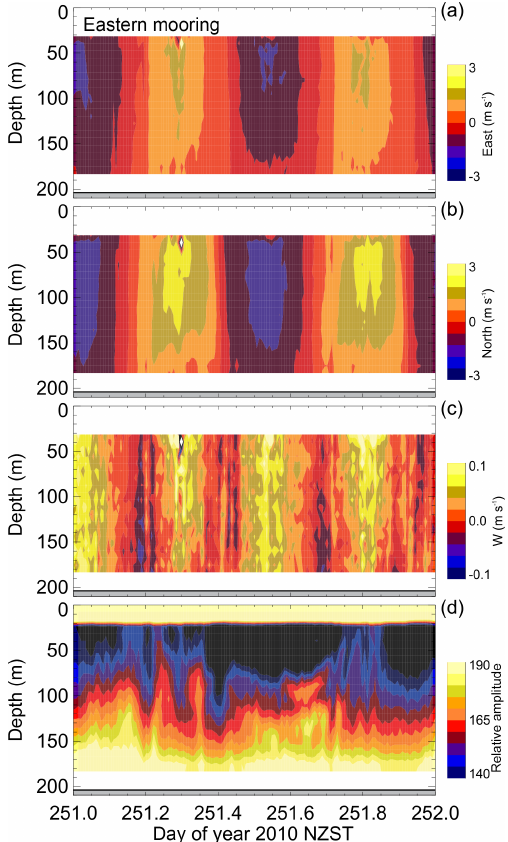
Figure 4. Velocity data from eastern side of strait showing (a) east– west (eastward is positive), (b) north–south (northward is positive), (c) vertical velocities and (d) backscatter amplitude.